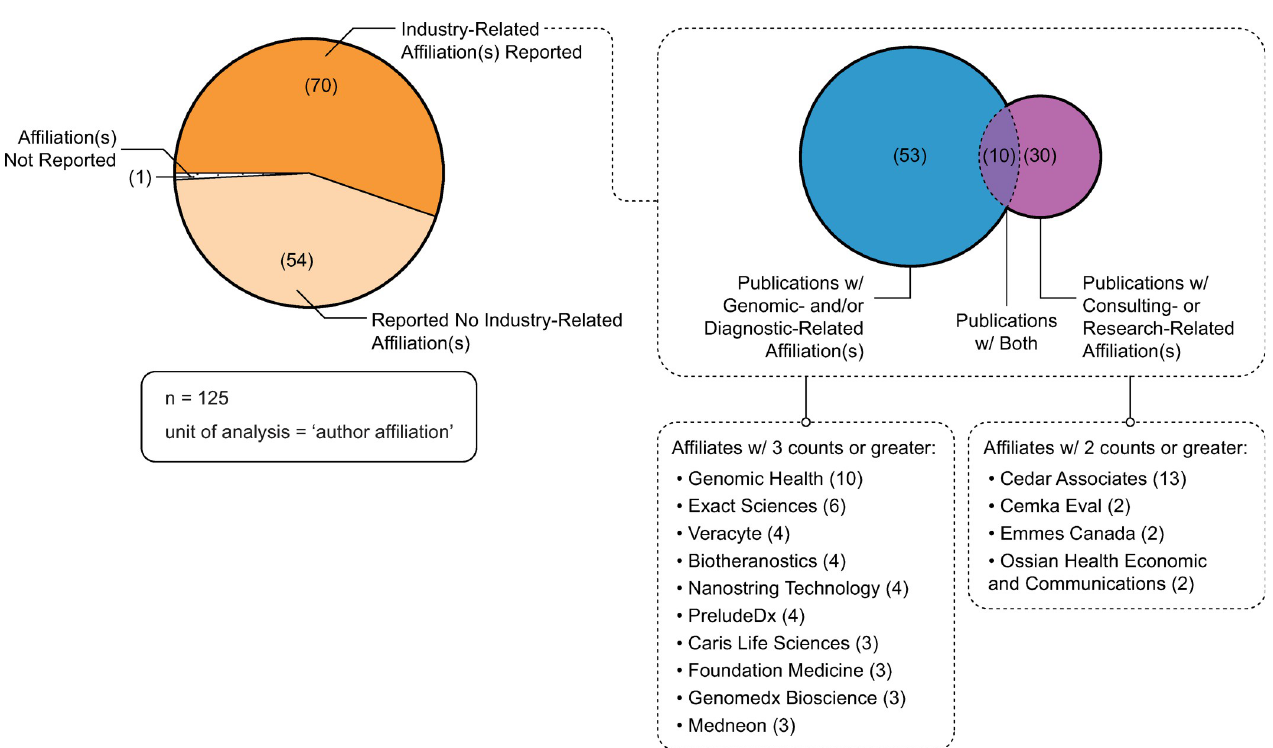
Fig 10. Industry-related affiliations, genomic- and diagnostic-related and consulting- and research organization-related. Source: Microsoft Excel was used to facilitate data analysis; Adobe Illustrator was used to facilitate data visualization.